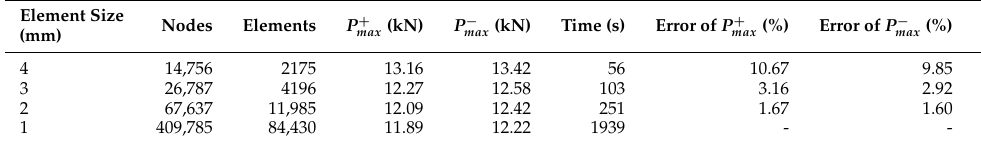
Table 2. Mesh convergence with respect to element